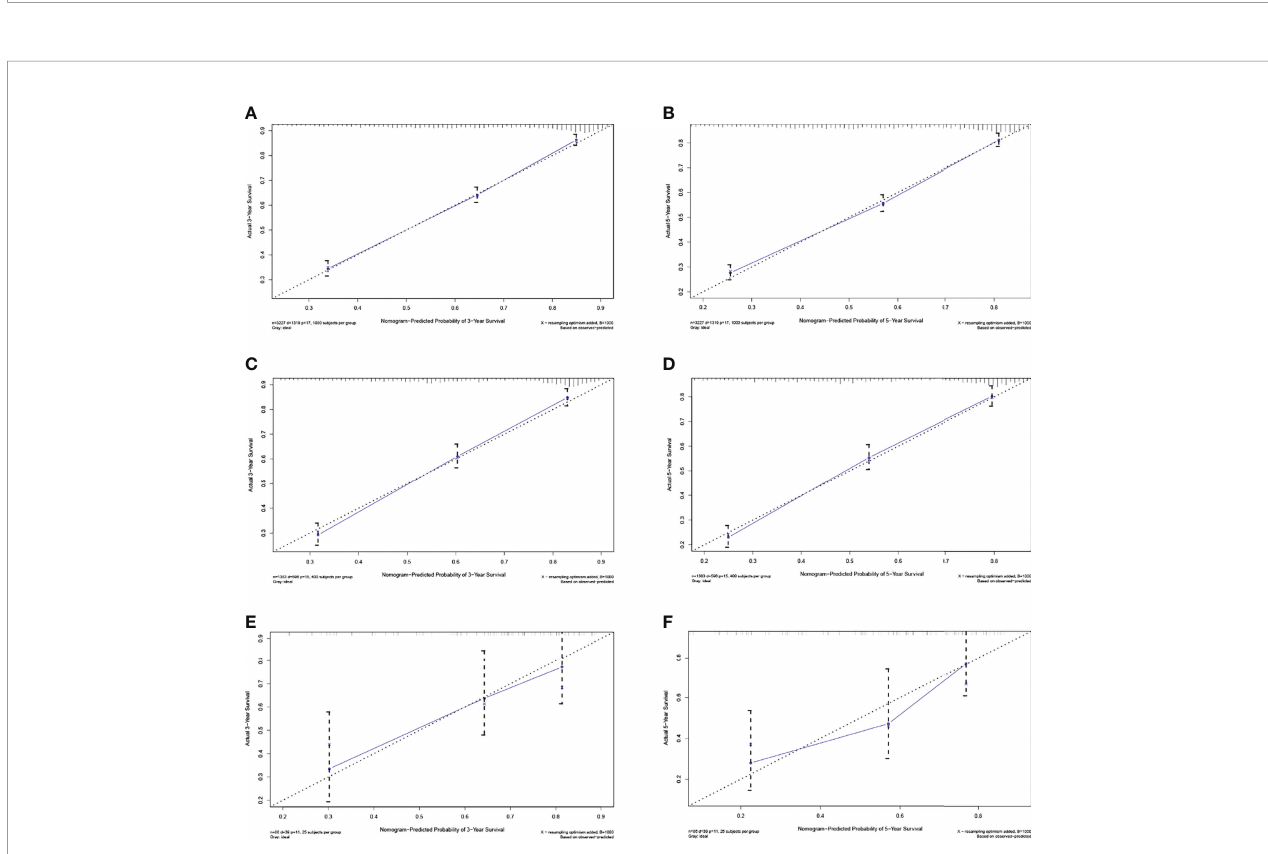
FIGURE 4 | The calibration curves of CSS nomogram at 3- (A) , and 5-years (B) in the primary cohort, at 3- (C) , and 5-years (D) in the internal validation cohort and at 3 (E) , and 5-year (F) in the external validation